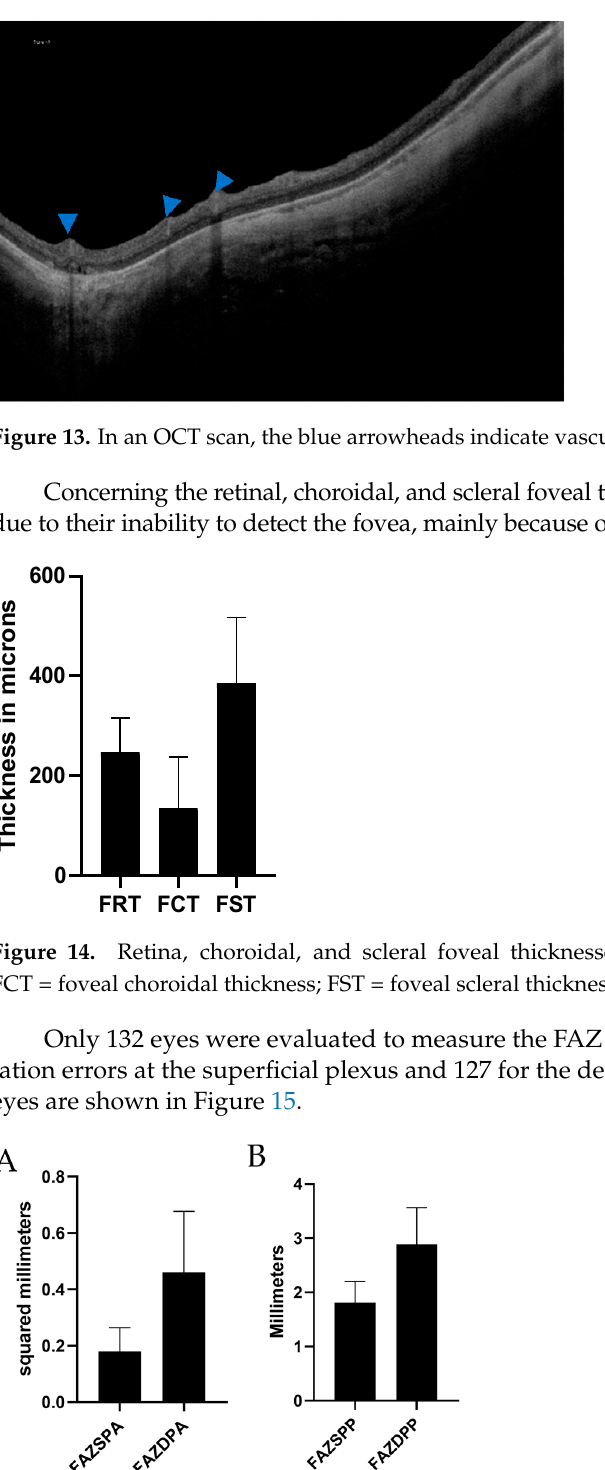
Figure 12. In the OCT scans, the blue arrowheads indicate intrachoroidal cavitation (ICC). ( A ) A small ICC is near the optic nerve head. ( B ) A large ICC is in the vicinity of the CNV (red arrowhead). Seventy-seven eyes (43%) had vascular folds in the HD51 scan (Figure 13). PSV were detected in 159 eyes (88.8%) and 16 of them were related to a Fuch´s spot and 4 eyes with active CNV. Seven eyes had PSV with lacquer cracks.